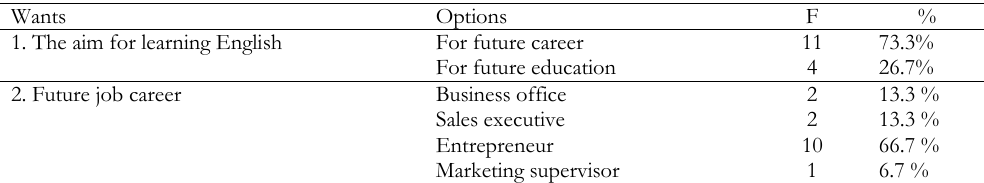
TABLE 2. Students’ view about purposes for learning English and uses English for their future work domain. Wants Options F %